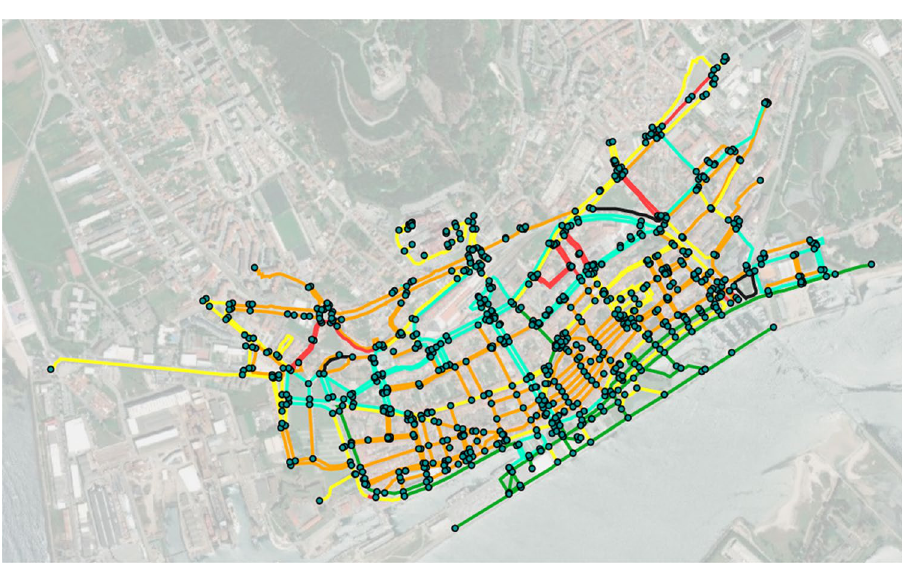
Fig. 1 Graph representation of the historic centre of Viana